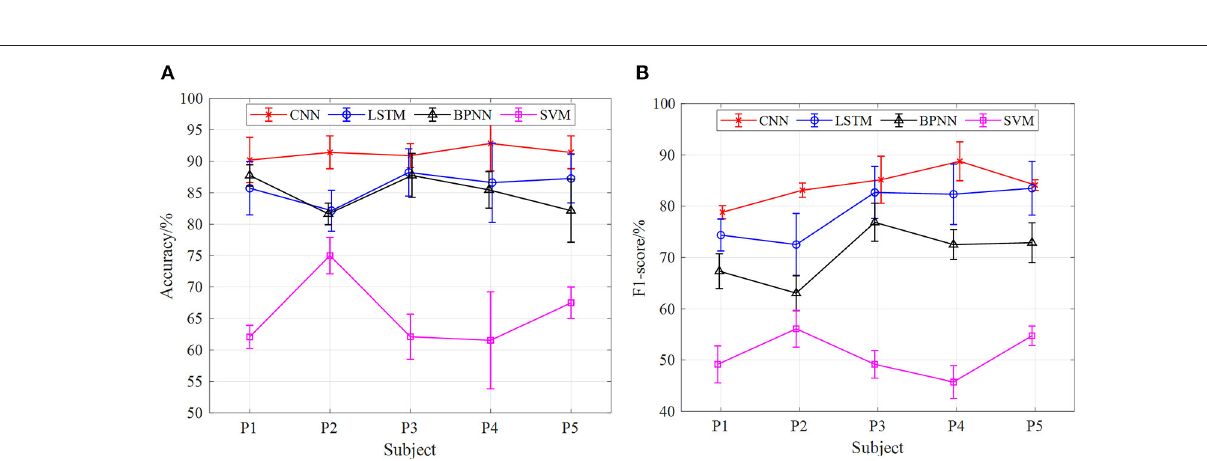
FIGURE 10 | The results of gait phase classification of different models with the 5-fold cross-validation method at 3km/h, (A) the average accuracy of gait phase classification of different models of five subjects, (B) the average F1-score of gait phase classification in different models of five subjects.